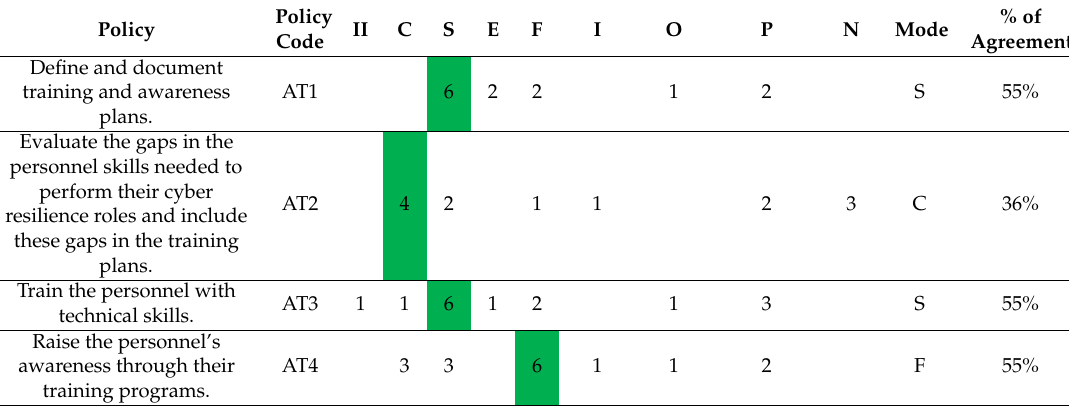
Table 18. Awareness and training policies’ progression